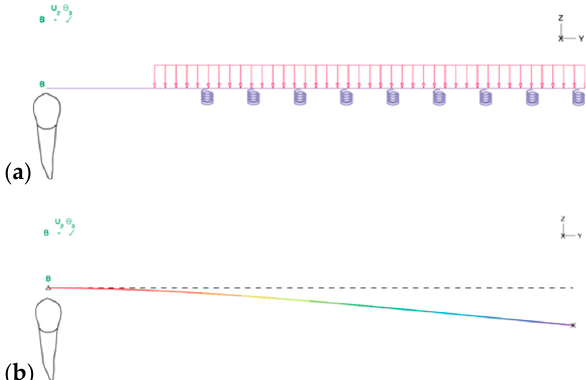
Figure 8. Representative images of the unilateral extension base of a removable partial denture as a modified cantilever beam Euler–Bernoulli problem: ( a ) The tooth represents the hinge support, allowing free rotation of the cantilever portion of the beam; The springs represent the vertical resistance promoted by the soft tissue underlying the extension base of the RPD; Occlusal load as distributed load exclusively over the replacement teeth. ( b ) Schematic representation of the pattern of vertical displacement occurring in each of the extension bases of a Kennedy Class I removable partial denture as a cantilever beam Euler–Bernoulli problem.